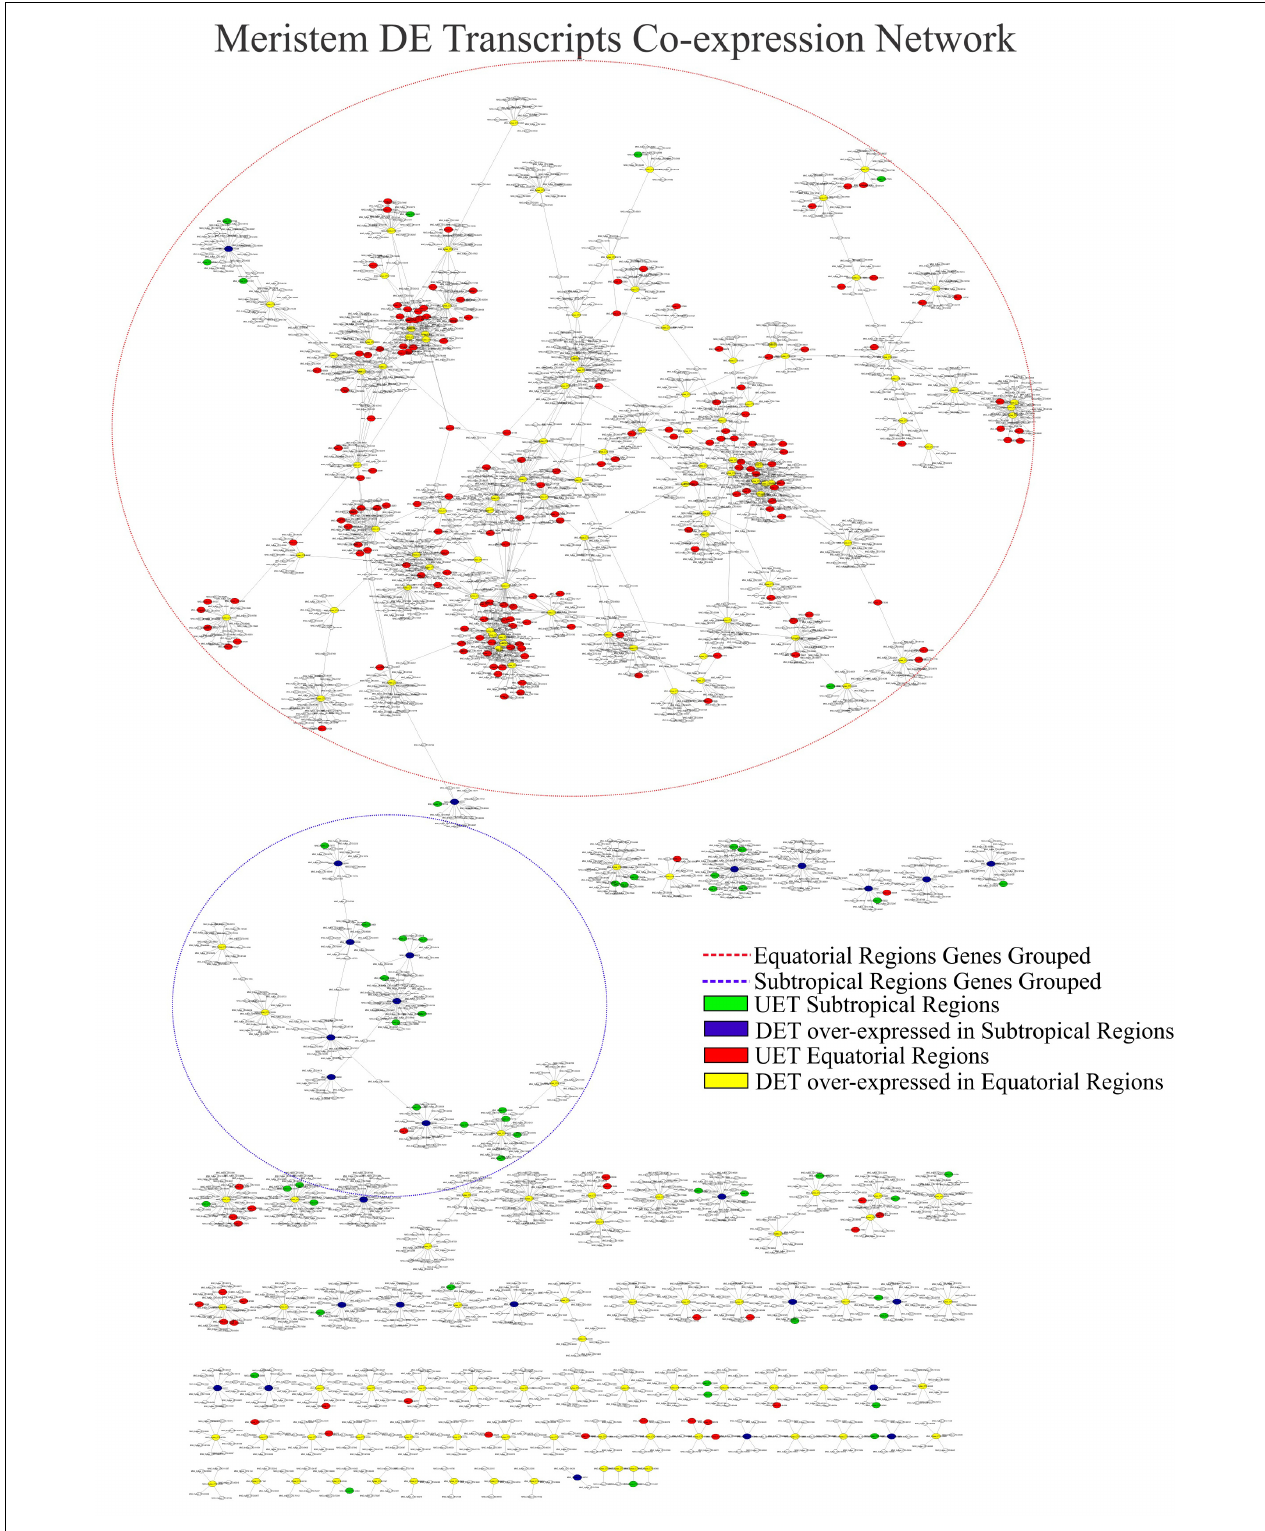
FIGURE 8 | Correlation networks of meristem transcript expression in Rhizophora mangle . Circular nodes represent transcripts and edges represent the correlation between pairs of transcripts. The figures show differentially expressed transcripts (DETs) between populations and their first neighbors. A blue circle highlights one of the largest clusters of these networks, with a predominance of UETs and over-expressed transcripts detected in subtropical samples. A red circle highlights one of the largest clusters of these networks, with a predominance of UETs and over-expressed transcripts detected in equatorial samples.